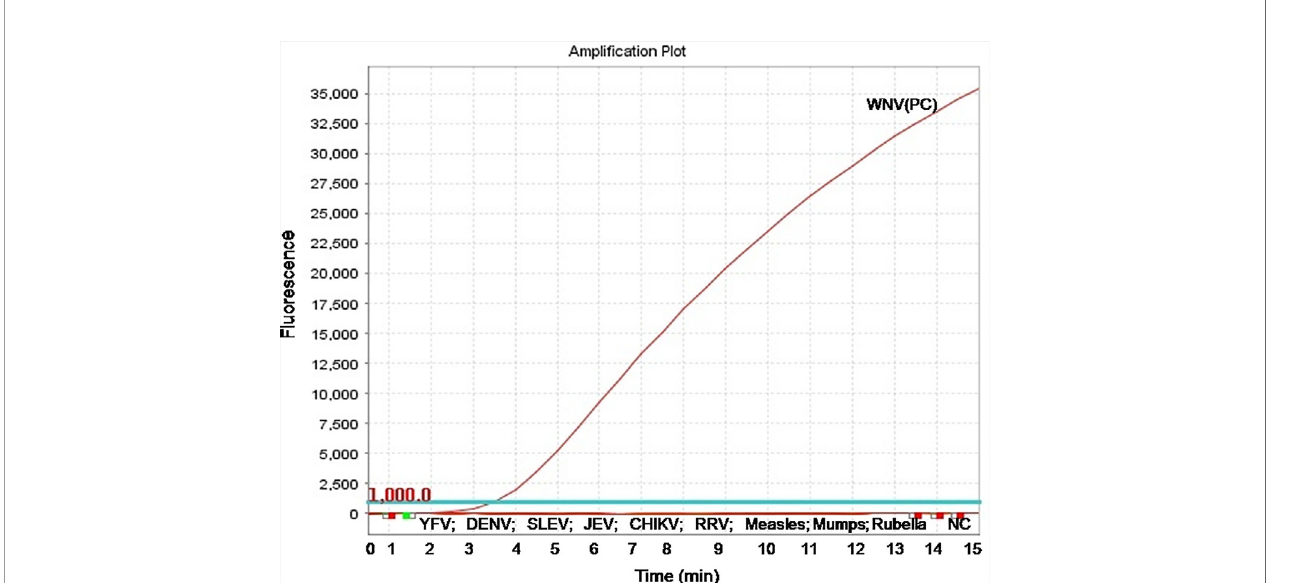
FIGURE 2 | Speci fi city test results of real-time reverse transcription recombinase polymerase ampli fi cation (RT-RPA) assay. The assay was tested for the speci fi city with RNA of Yellow fever virus, Dengue virus, Saint Louis Encephalitis virus, Japanese Encephalitis virus, Chikungunya virus, Ross River virus, Measles virus, Mumps virus, and Rubella virus.